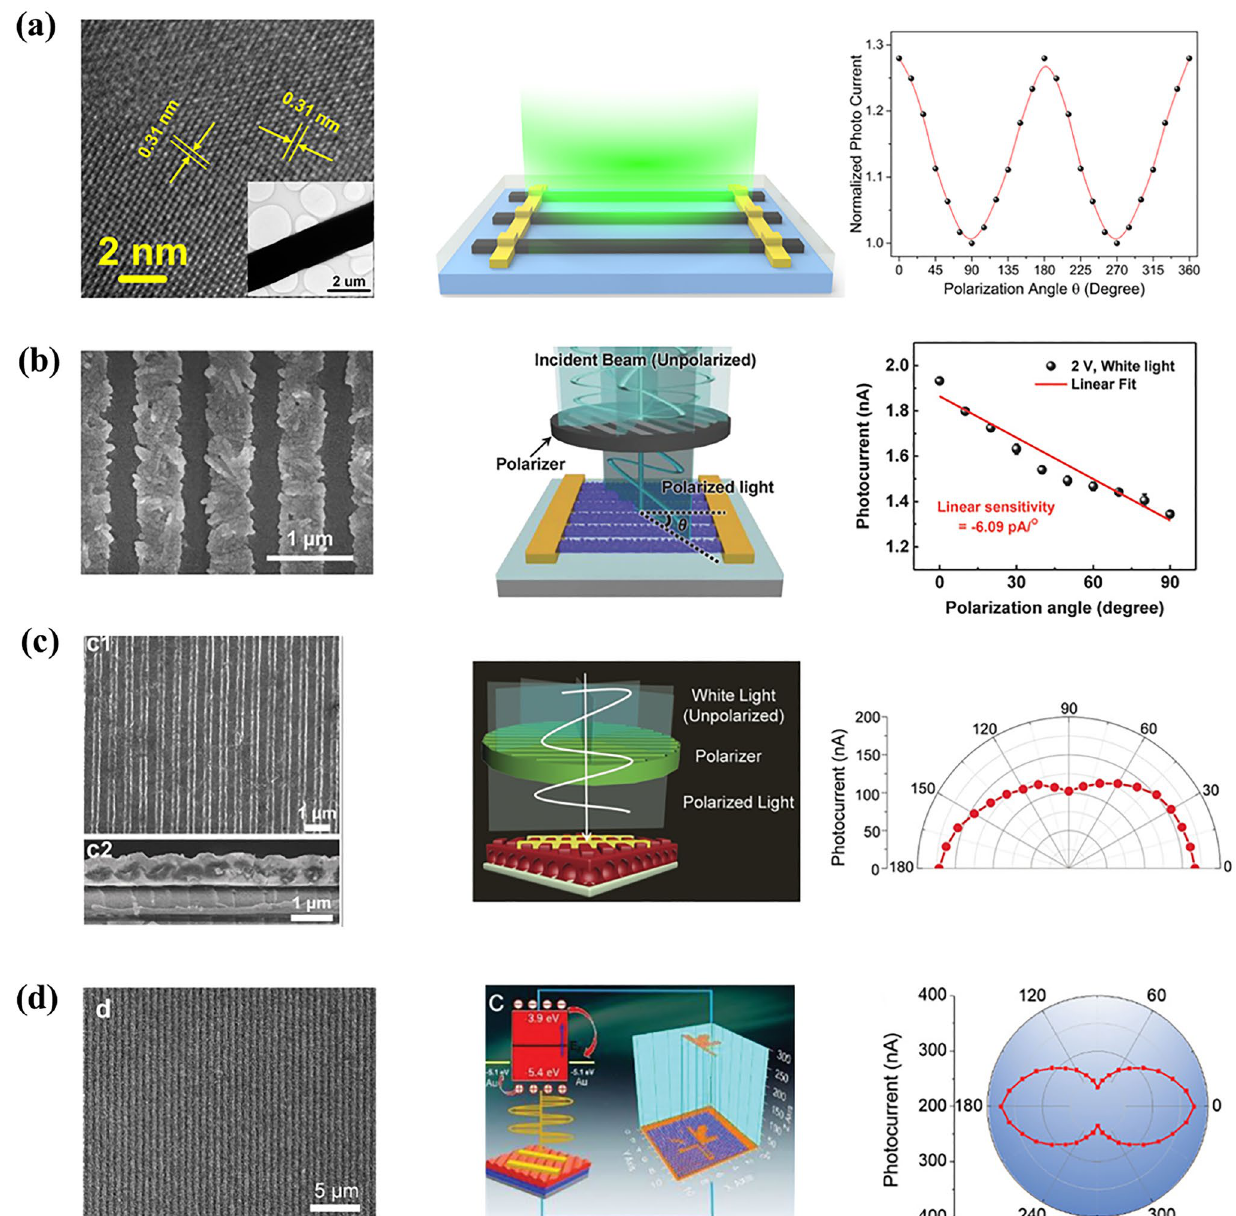
Fig. 1 Performance of LP-PPDs based on CH 3 NH 3 PbI 3 with different optical structures. a 1D nanowire arrays. Reproduced with permission [5], Copyright 2016, American Chemical Society. b 1D nanoribbon arrays. Reproduced with permission [7], Copyright 2018, John Wiley and Sons. c 1D nanograting with 2D photonic crystal. Reproduced with permission [9], Copyright 2019, John Wiley and Sons. d Stacked dual grating. Reproduced with permission [10], Copyright 2021, John Wiley and